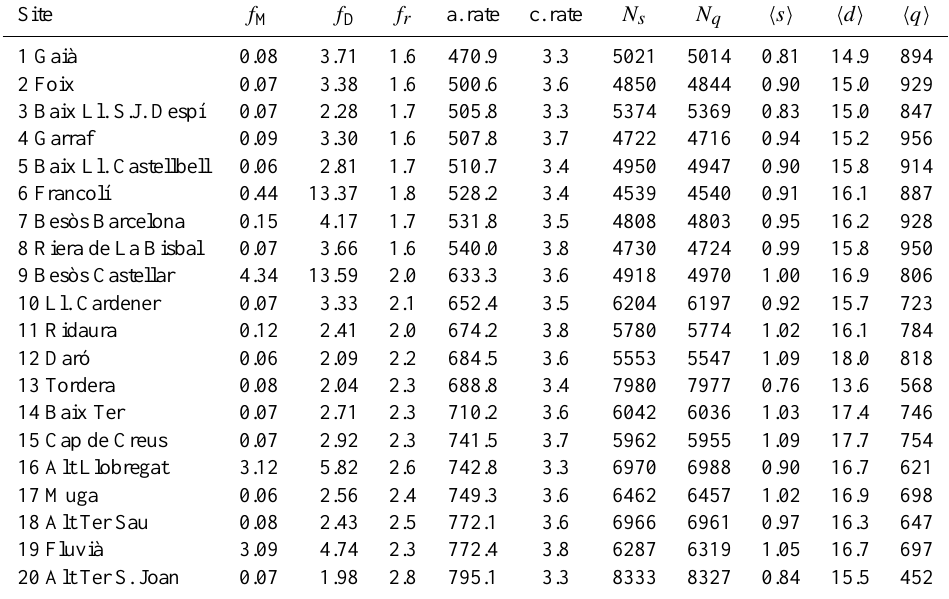
Table 1. Characteristics of all the sites for the 9-year period 2000–2008. Every site is named by the corresponding river basin or subbasin (the municipality is included in ambiguous cases); Ll. stands for Llobregat river; f M is the fraction (in %) of missing records (time missing divided by total time); f D is the fraction (in %) of discarded times; f r is the fraction (in %) of rainy time (time with r > 0 divided by total non-discarded time, for a time resolution 1t = 5min); a.rate is the annual rain rate in mmyear − 1 , calculated only over non-discarded times; c.rate is the rain rate in mmh − 1 conditioned to rain, i.e., calculated over the (non-discarded) rainy time; N s is the number of rain events and N q the number of dry spells (the differences between N s and N q are due to the missing records); the rest of symbols are explained in the text. h s i is measured in mm, and h d i and h q i in min. Sites are ordered by increasing annual rate. The table shows a positive correlation between f r , the annual rate, N s and N q , and that these variables are negatively correlated with h q i . In contrast, the rate conditioned to rain is roughly constant, taking values between 3.3 and 3.8mmh − 1